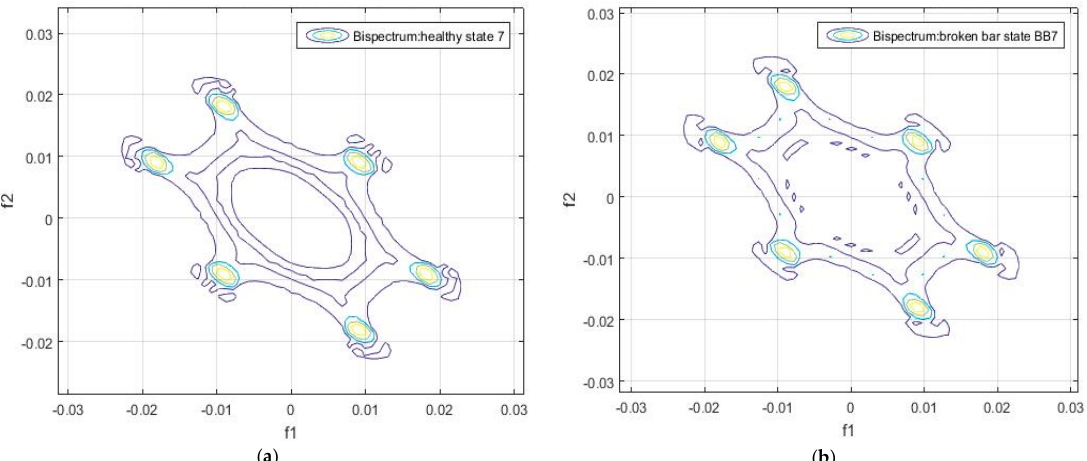
Figure 9. Contour of the bispectrum of the motor flux signal: ( a ) Sample 7 of the healthy motor, and ( b ) Sample 7 of the damaged motor Table 6. Results of the indicator in the frequency domain based on Equations (4) and (5) for the data of the experiment with the healthy motor during start-up.